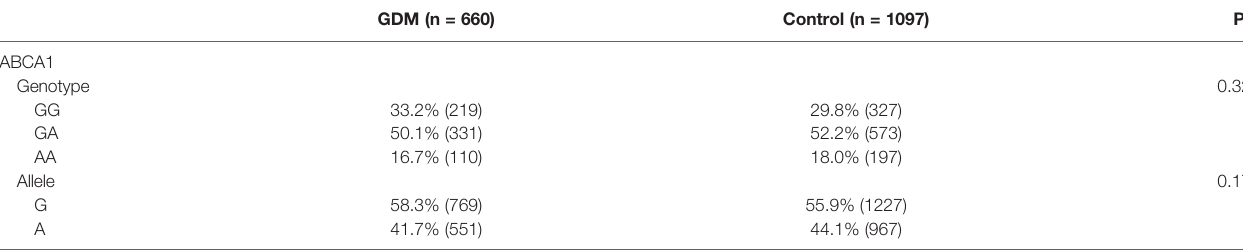
TABLE 2 | Genotype and allele frequency for the rs2230806 SNP of the ABCA1 gene in women with GDM and control subjects.